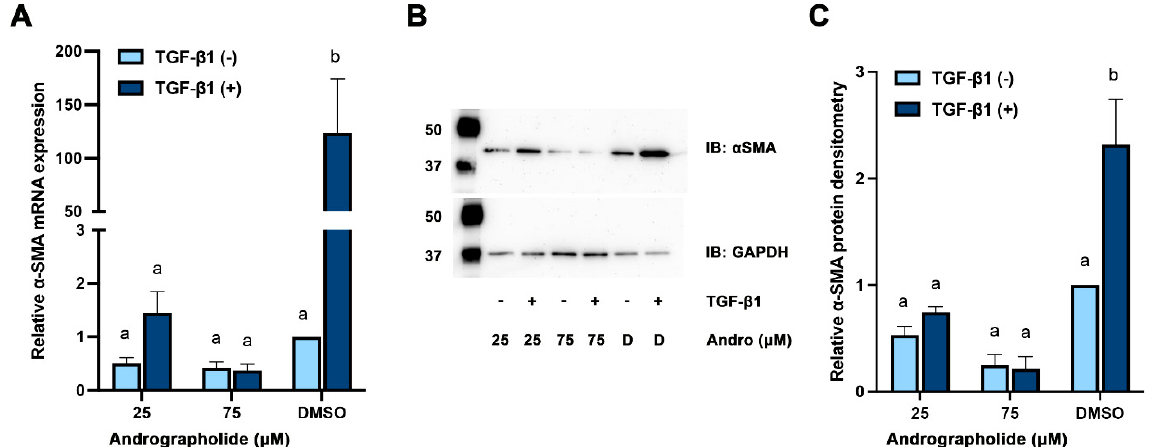
Figure 2. Treatment with andrographolide inhibits the TGF- β 1-induced transdifferentiation of corneal fibroblasts into myofibroblasts. Primary rabbit corneal fibroblasts were treated with andrographolide (25 and 75 µ M) or vehicle control (DMSO) in the presence or absence of TGF- β 1 (10 ng/mL). ( A ) RT- qPCR was performed to measure the relative α SMA expression normalized to GAPDH. ( B ) Western blotting was performed with mouse monoclonal antibodies for α SMA or GAPDH, detected with a rabbit α -mouse HRP labelled secondary antibody and imaged using chemiluminescence. Ladder indicating 50 and 37 kDa. ( C ) Band densitometry was performed using ImageJ with normalizing α SMA to GAPDH, and further normalized to vehicle control without TGF- β 1. Bars indicate mean expression and error bars indicate standard deviation ( n = 3 independent experiments). Ladder present (kD). IB: immunoblot, Andro: Andrographolide, D: DMSO. Two − way ANOVA performed with a Šidák’s multiple comparisons test and different letters indicate statisti-